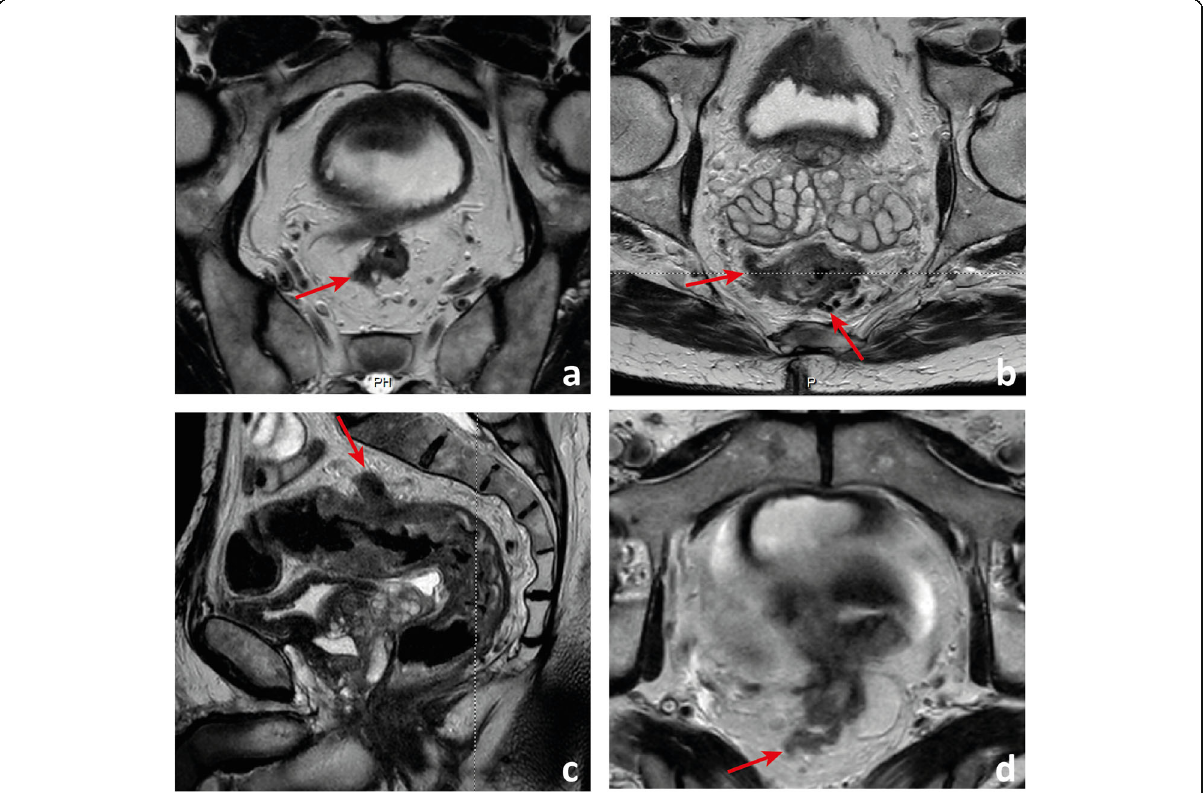
Fig. 14 MR extramural venous invasion (mrEMVI) is characterised by the presence of intermediate signal intensity tumour signal within vessels, which may be expanded (arrows in a to d ) with (arrow in a ) or without contour